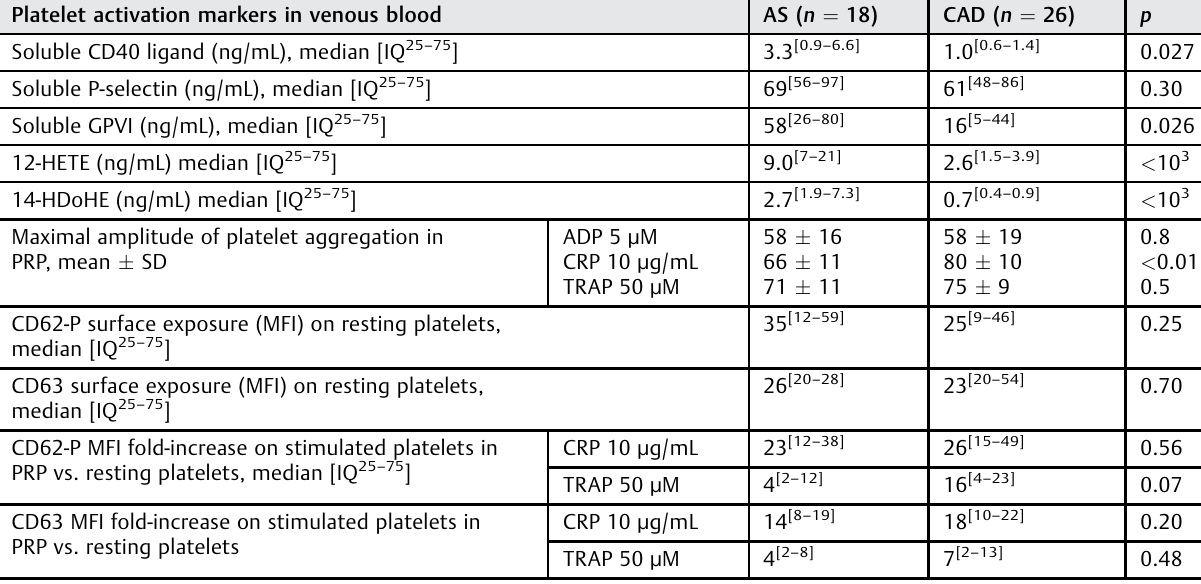
Table 2 Baseline platelet activation markers and in vitro platelet reactivity in AS before TAVI and control groups Platelet activation markers in venous blood